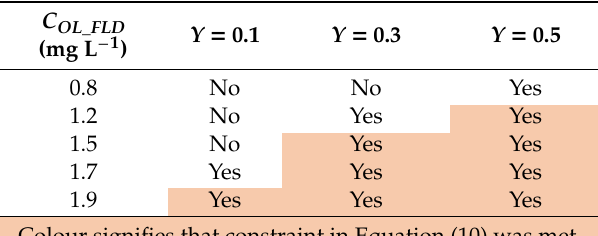
Table 3. E ff ect of Y and C OL_FLD on whether or not unwanted Pag step increases occurred (Yes / No) (set-point C OL = 2 mg L − 1 ).